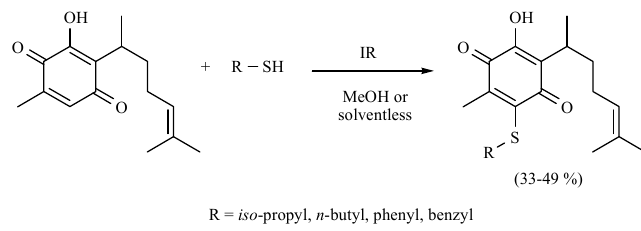
Scheme 10. Obtention of sulfur-derivatives of perezone.